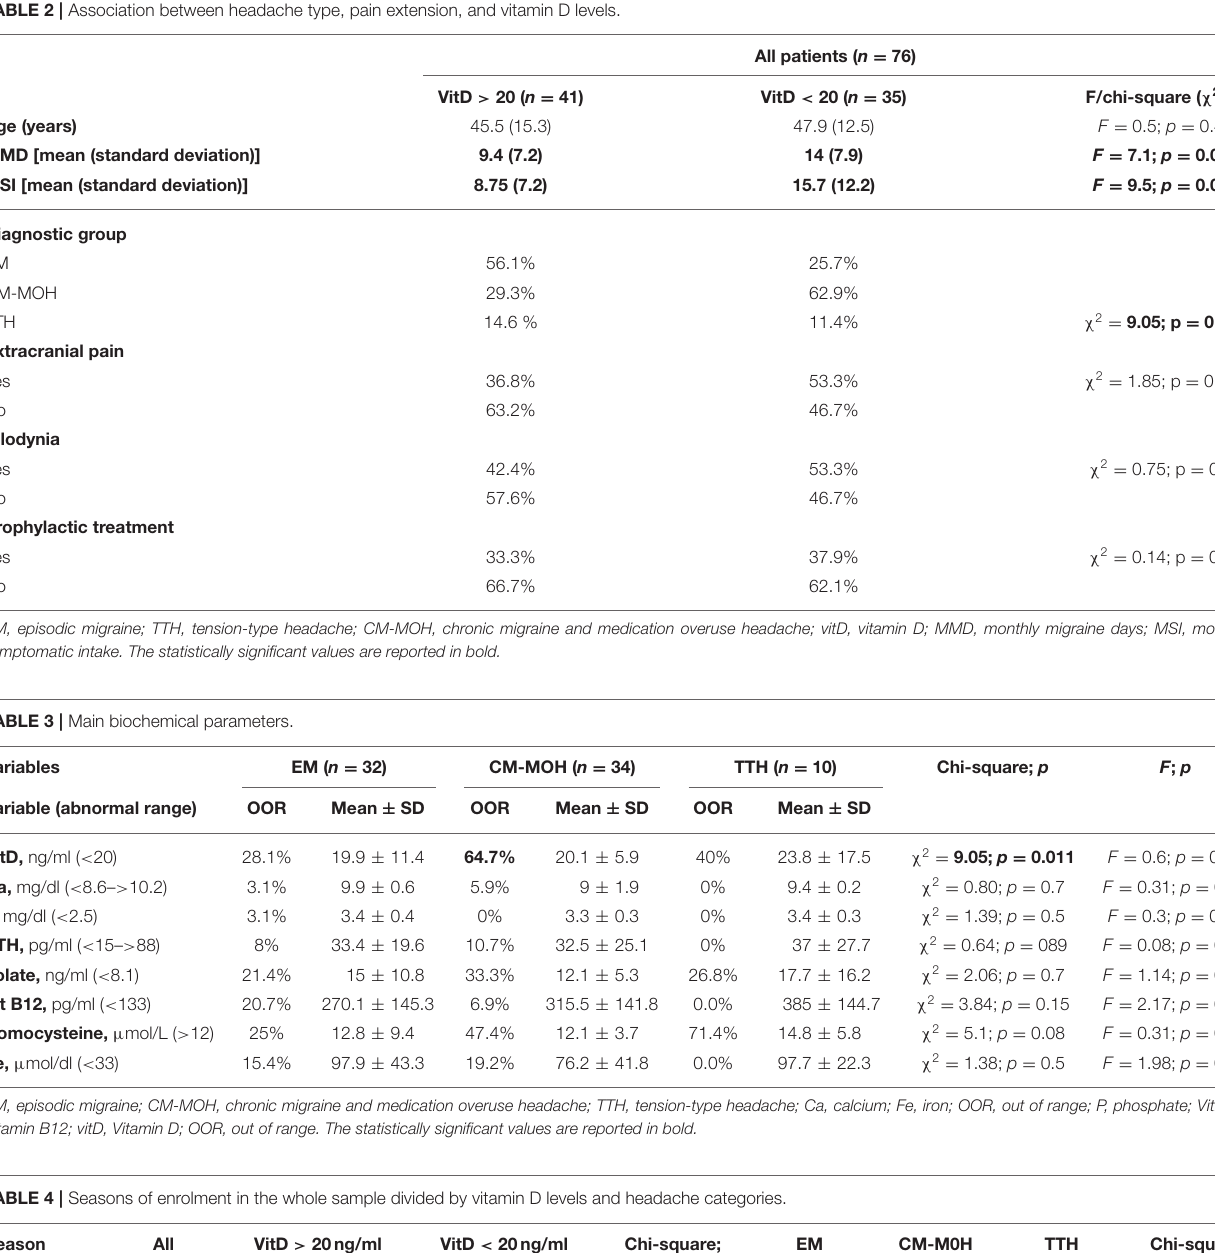
TABLE 2 | Association between headache type, pain extension, and vitamin D levels.